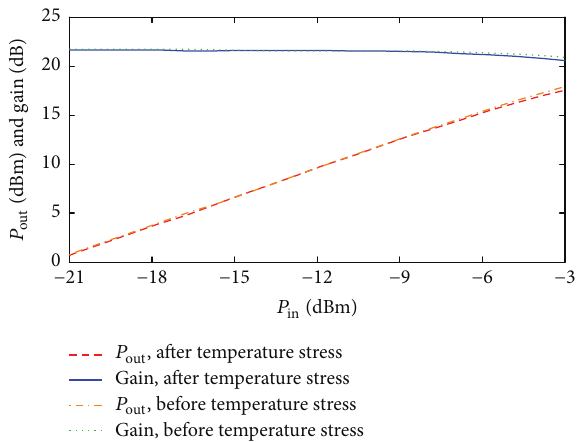
Figure 9: The output power and gain against input power before (blue color traces) and after (red color traces) temperature stress under transmission mode.